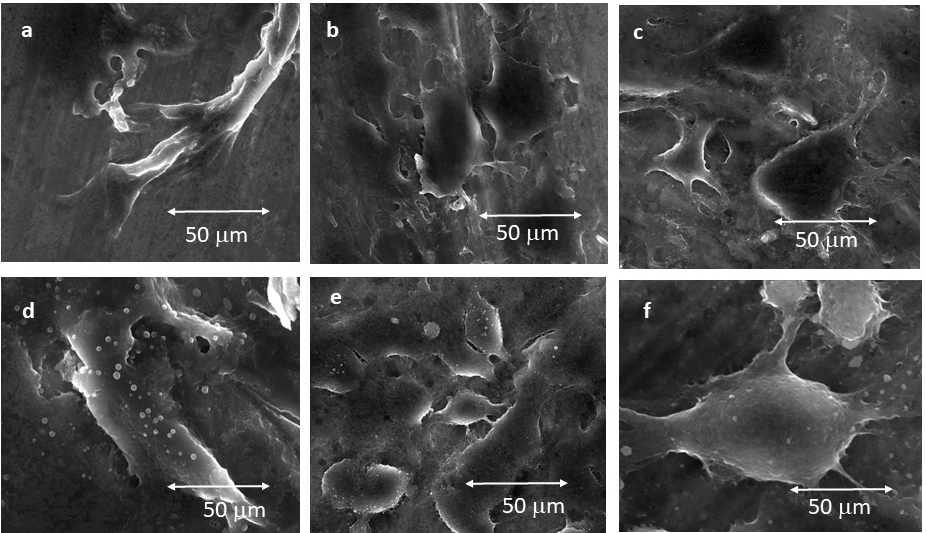
Figure 6. FESEM images of fibroblasts morphologies: ( a ) Mech samples at 4 h; ( b ) Al2 samples at 4 h; ( c ) Al9 samples at 4 h; ( d ) Mech samples at 72 h; ( e ) Al2 samples at 72 h; ( f ) Al9 samples at 72 h.